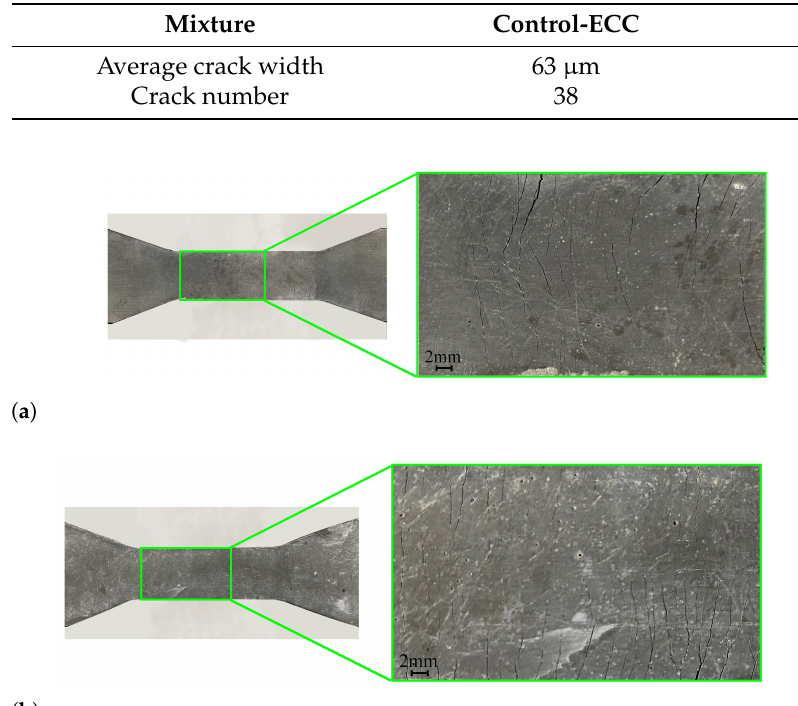
Figure 13. Cracking pattern of ( a ) control-ECC ( b )